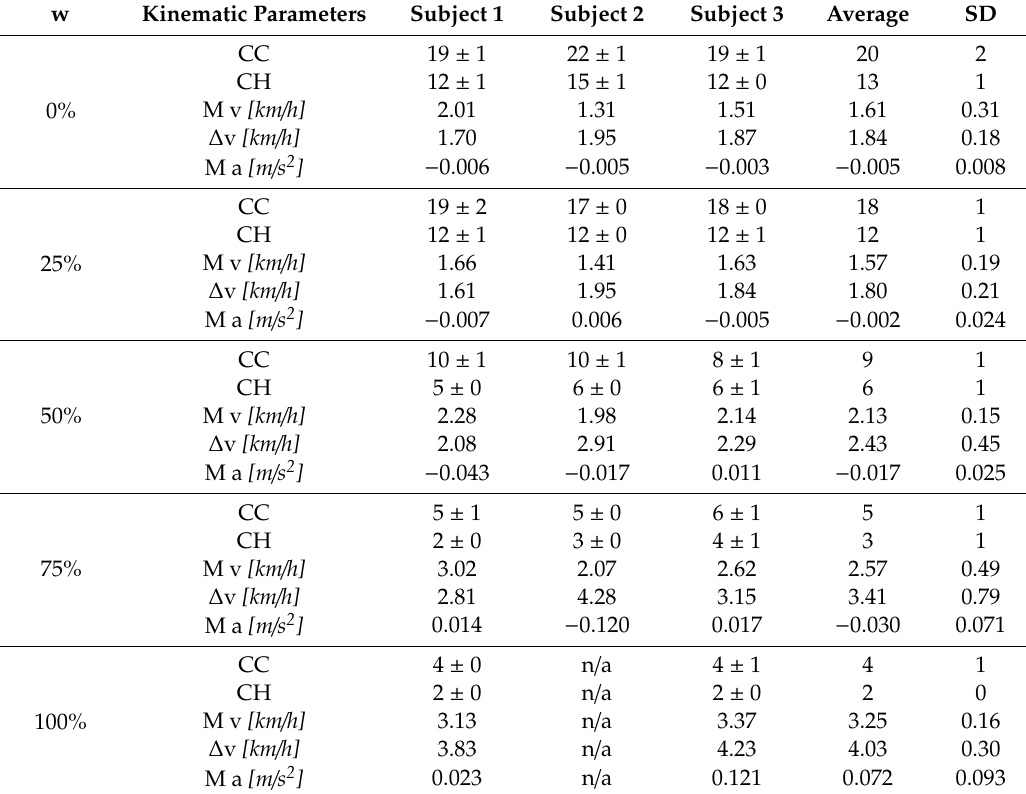
Table 4. Average values of analyzed kinematic parameters for amplification of the driving torque mode